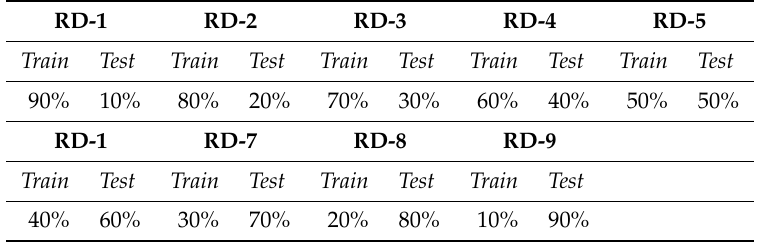
Table A3. Train and Test data distributions in nine Research Designs